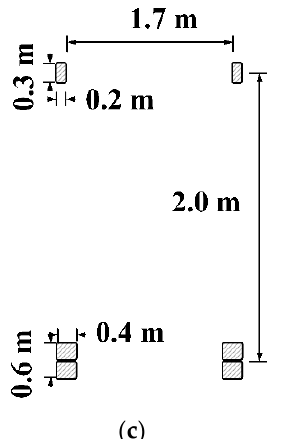
Figure 5. Simplified tire grounding area: ( a ) single-wheel; ( b ) double-wheel; ( c ) a ten wheels’ truck.